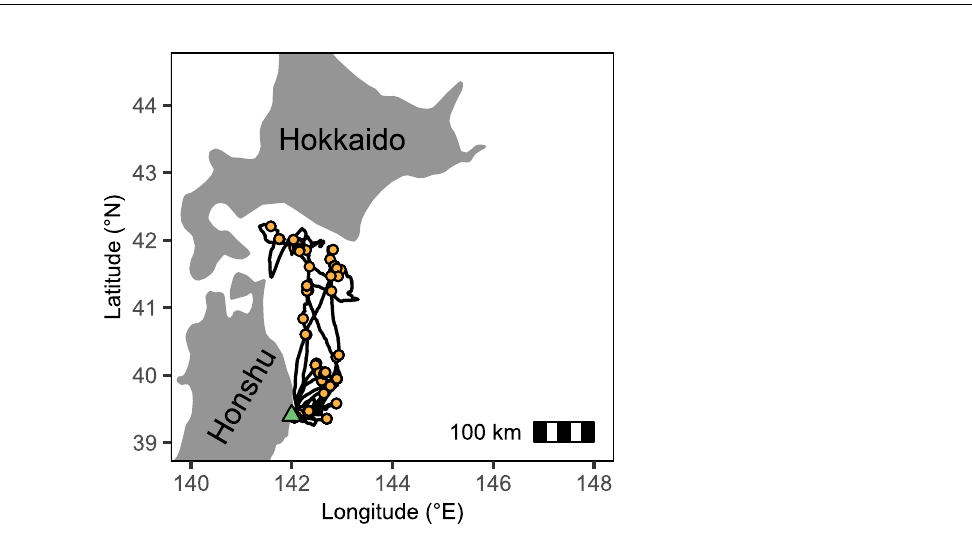
Fig 5. Example track and foraging locations of single individual. GPS track and foraging points (orange dots) of a single bird tracked over 12 days, 7 foraging trips. The nesting site is indicated by a green triangle.